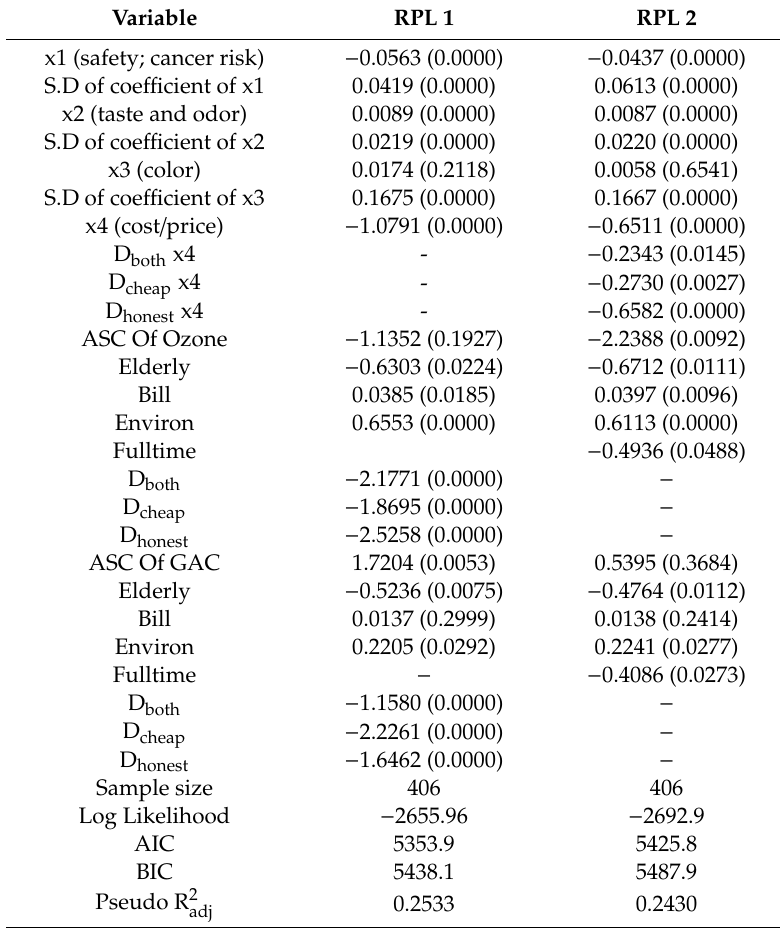
Table 2. Estimations of RPL (Random Parameter Logit) 1 and RPL